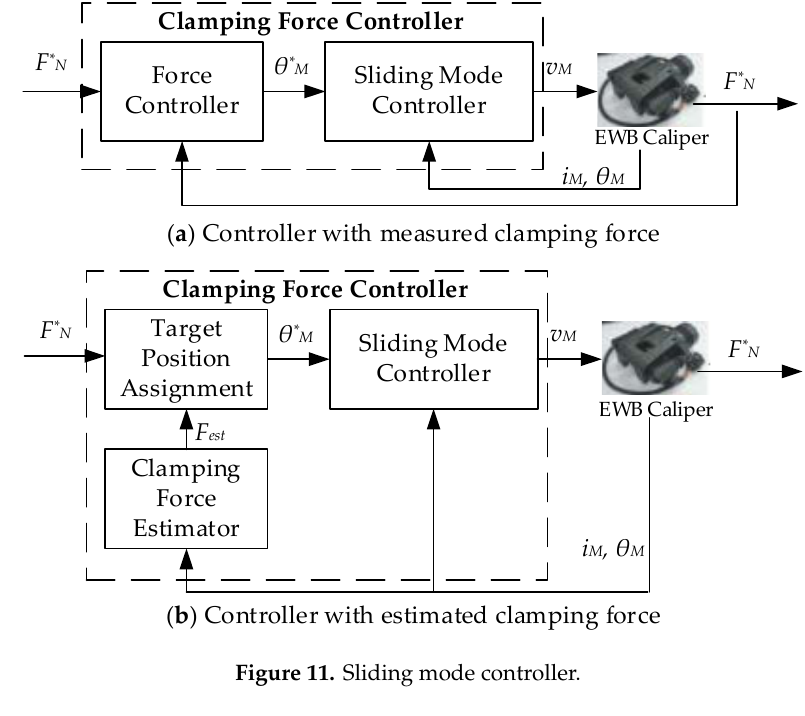
Figure 11. Sliding mode controller.